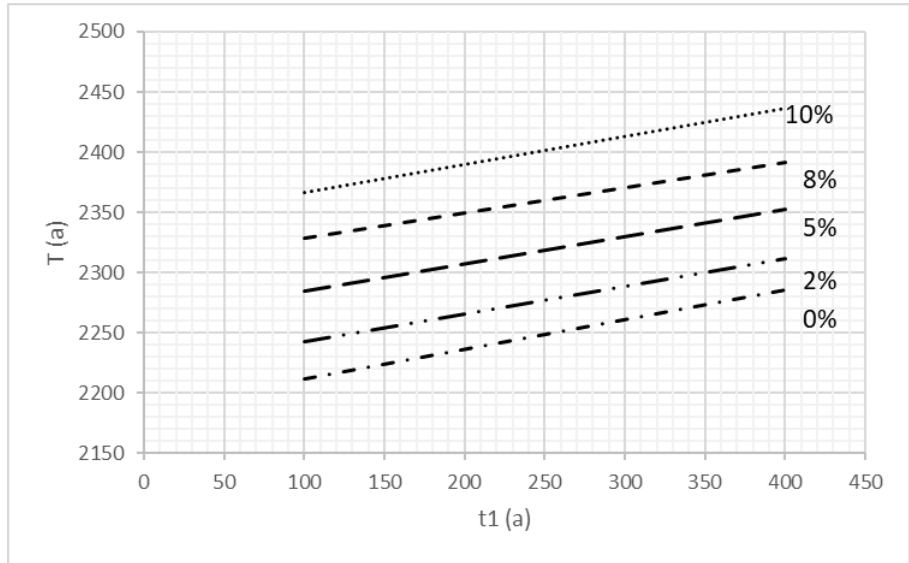
Figure 7. Time elapsed since the casting vs. the period of the outdoor location. Different concentra- tions of water in the burial environment were considered.